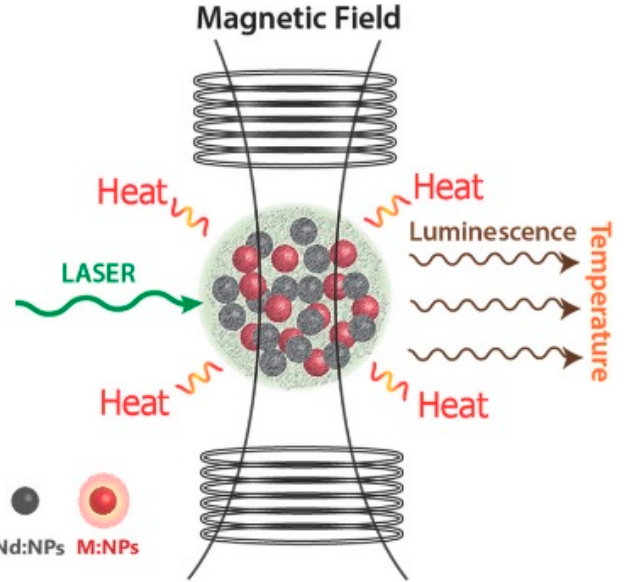
Figure 14. Scheme to illustrate an experiment of nanothermometry under a magnetic fi eld using a luminescent nanothermometer [239]. Reprinted (adapted) with permission from [239]. luminescent nanothermometer [239]. Reprinted (adapted) with permission from